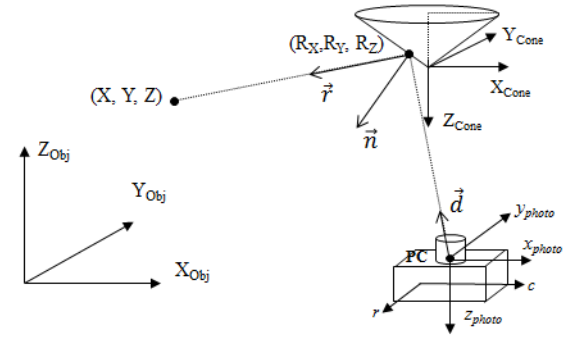
Figure 1: Coordinate reference systems of the omnidirectional catadioptric